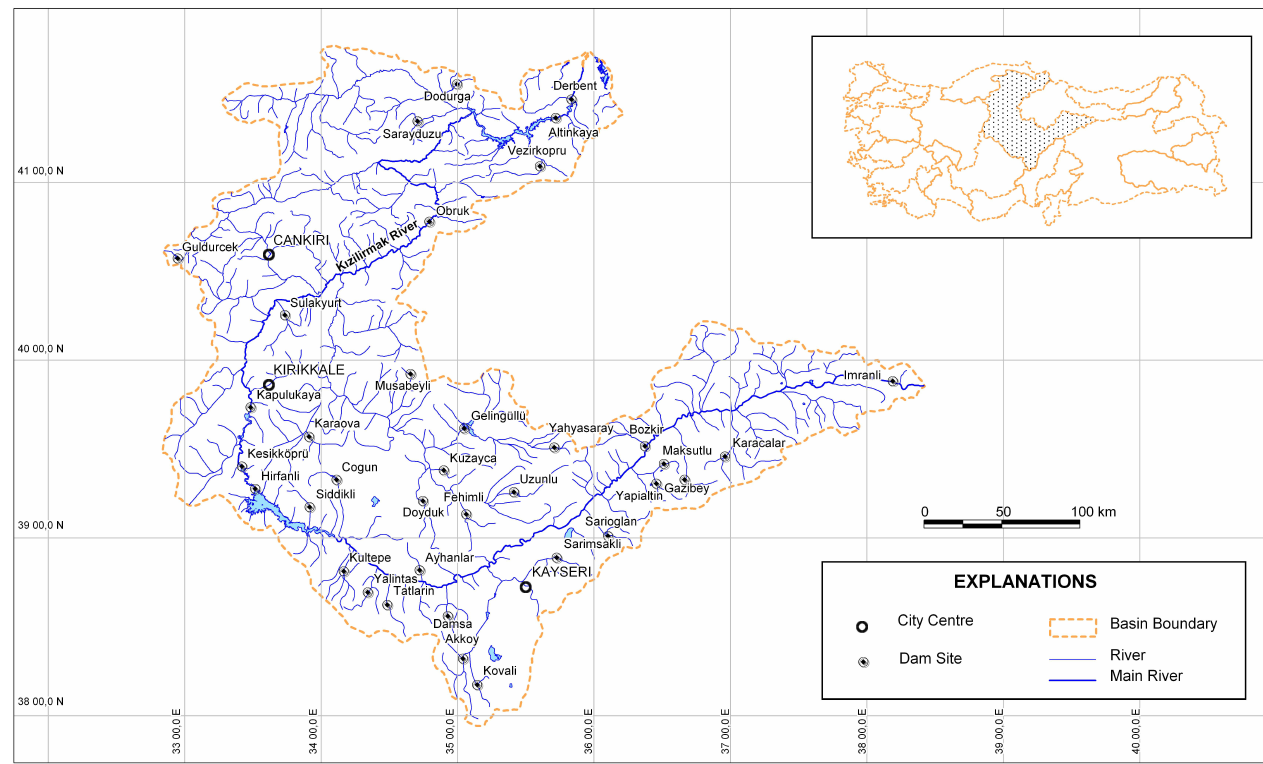
Fig. 1. The location of dams in the Kizilirmak